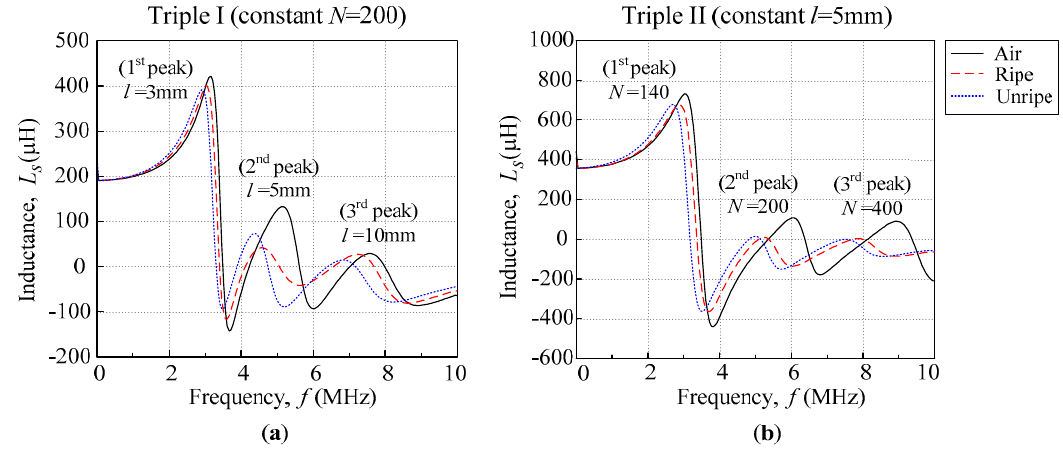
Figure 8. ( a ) Triple I and ( b ) Triple II L s – f curves for air, ripe, and unripe conditions.